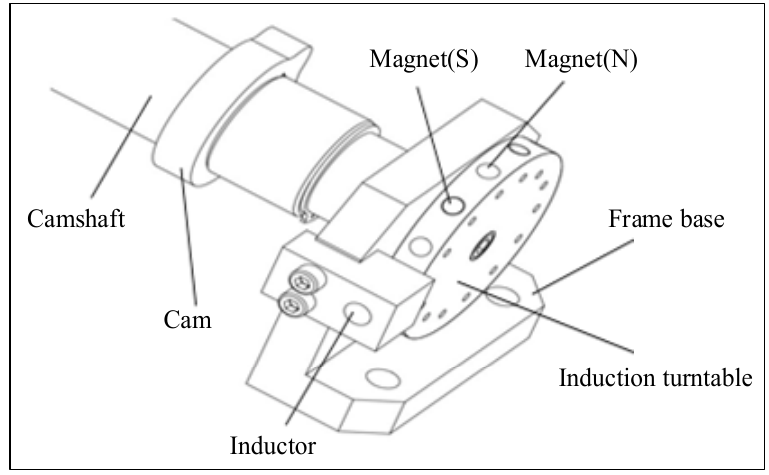
Figure 6. Schematic diagram of the induction device of the net opening and closing mechanism.